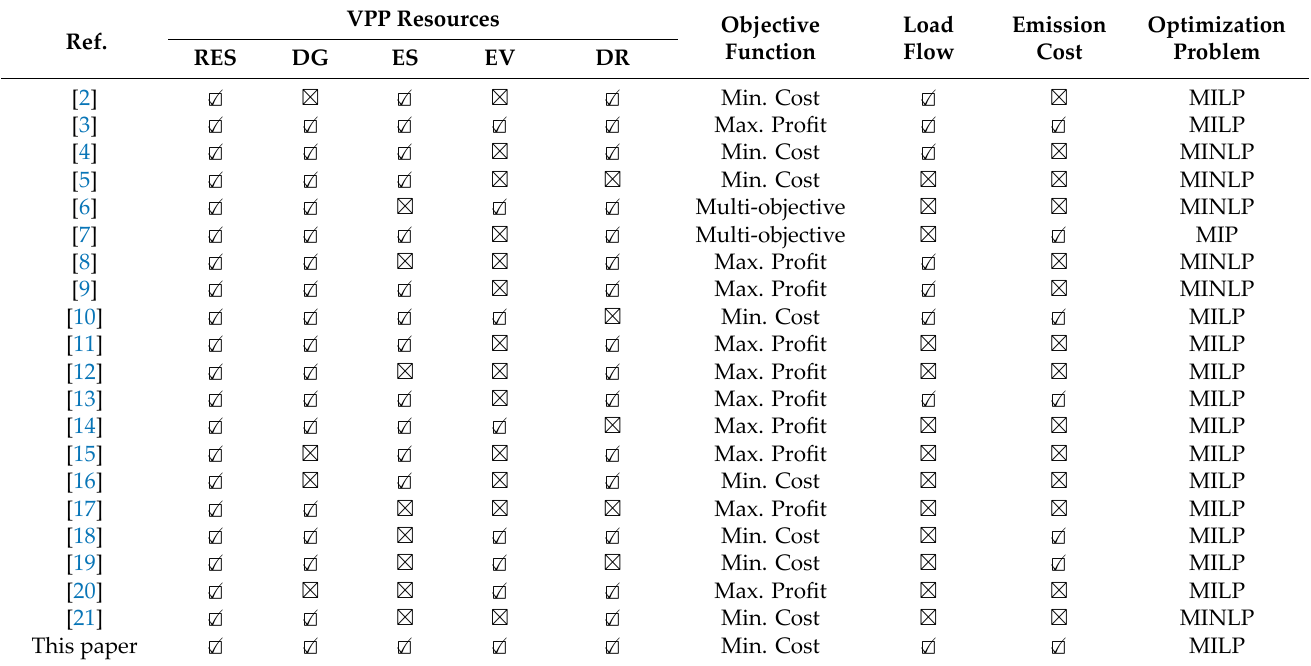
Table 1. A survey for VPPs’ energy management in the existing literature.